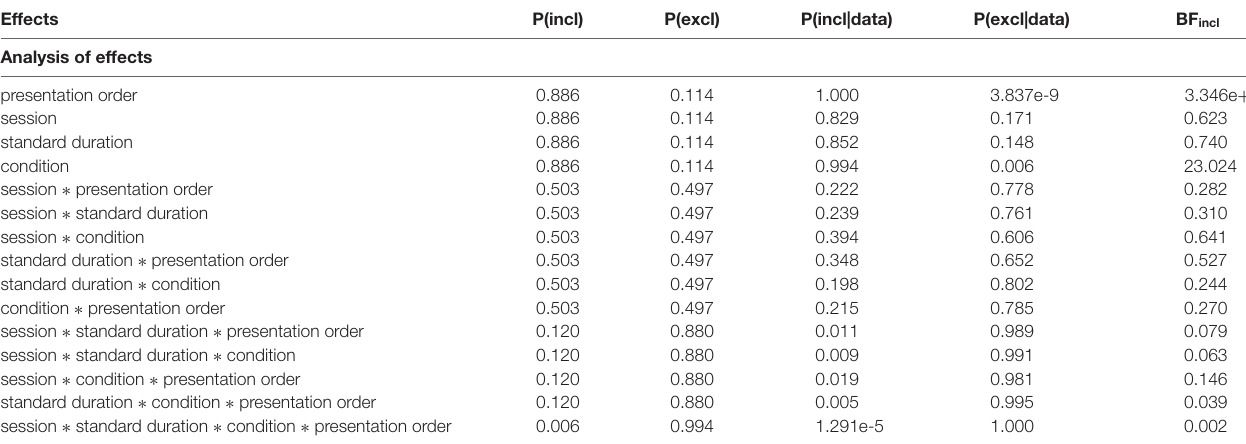
TABLE 4 | Bayes factors for inclusion calculated based on Bayesian model averaging for Weber fractions of Experiment